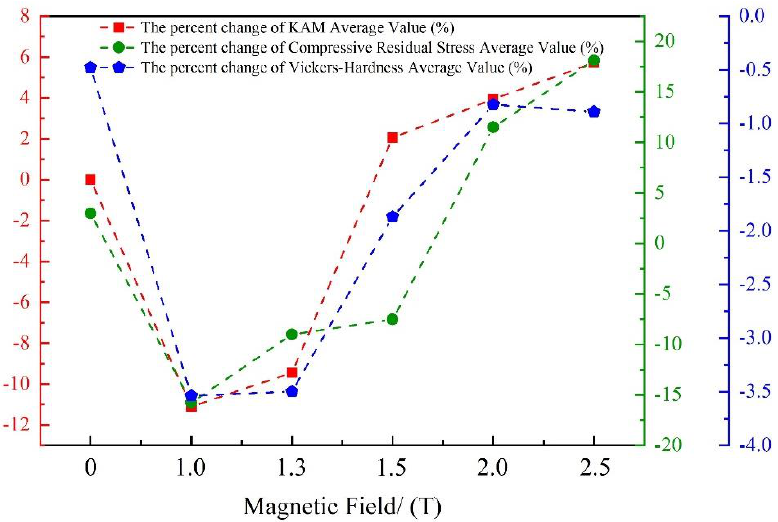
Figure 12. The percent change of the average value of KAM, residual stress, and Vickers hardness at different magnetic fields.